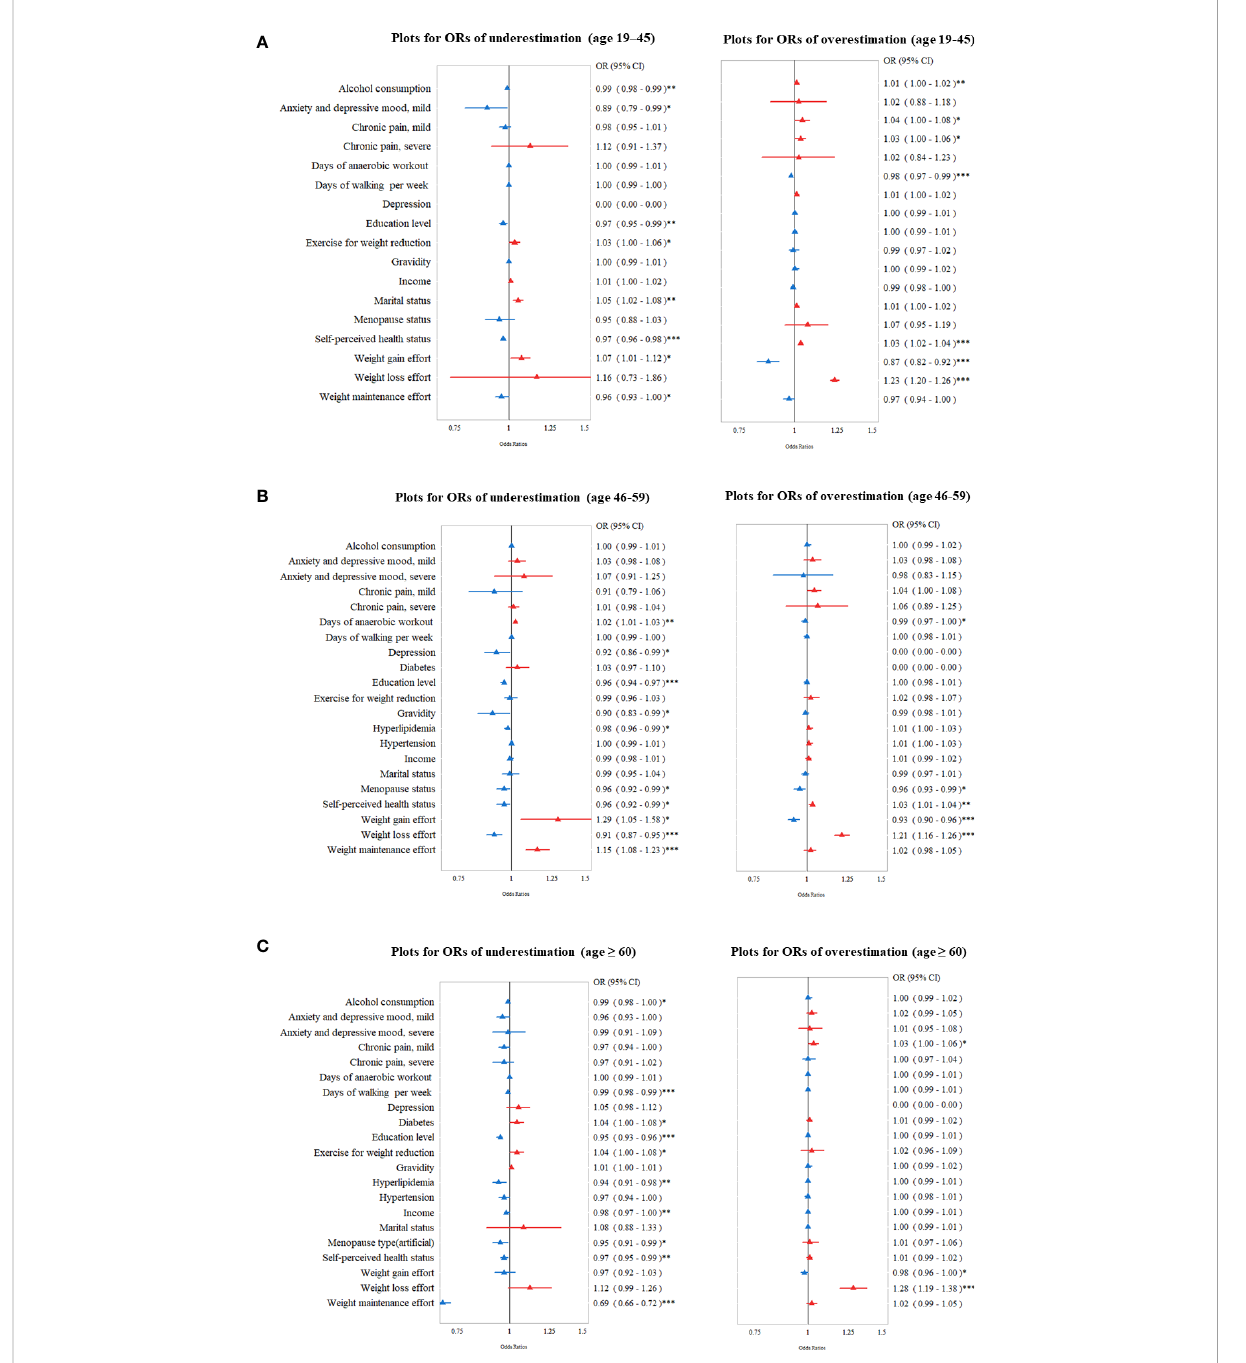
FIGURE 3 Odds ratio (OR; 95% con fi dence interval [CI]) of socioeconomic and health-related factors for body weight misperception (overestimation or underestimation) in different age groups: (A) 19 – 45 years (B) 46 – 59 years, and (C) ≥ 60 years. * P < 0.05, ** P < 0.01, *** P <